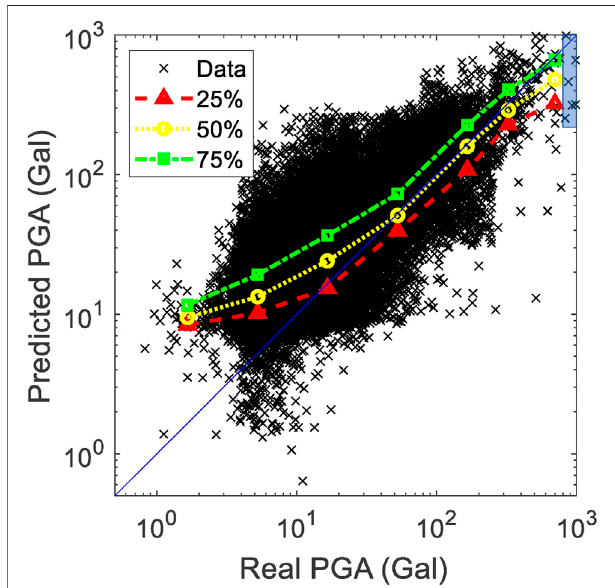
FIGURE 9| Comparison between the predicted PGA and actual PGA of the entire TSMIP data set using the proposed LSTM approach. The distribution of the earthquakes with real PGA larger than 800 Gal is marked with the blue box.